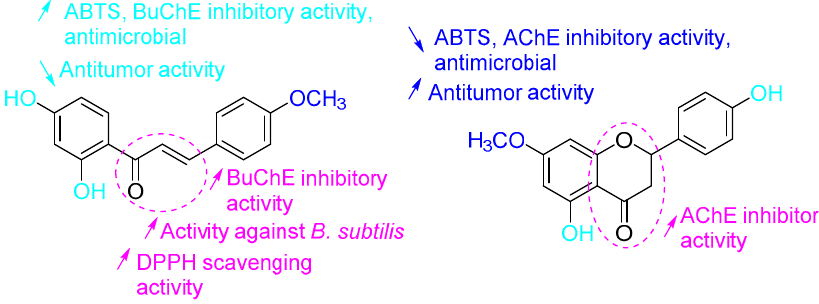
Figure 8. Summary of the most relevant structure/activity relationships established.